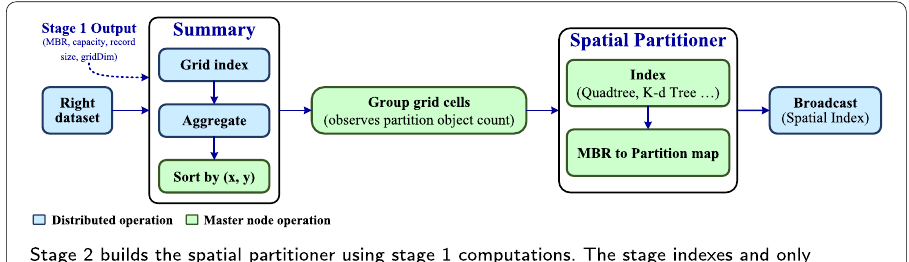
Fig. 5 Stage 2—constructing and indexing the partitioner